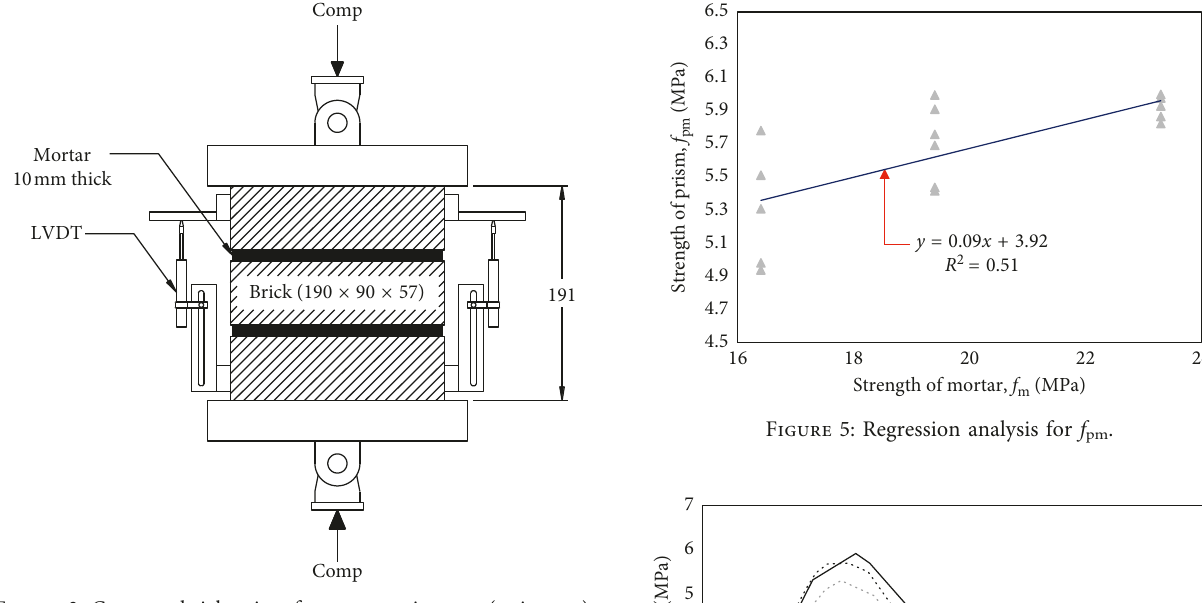
Figure 3: Concrete brick prism for compression test (unit: mm).